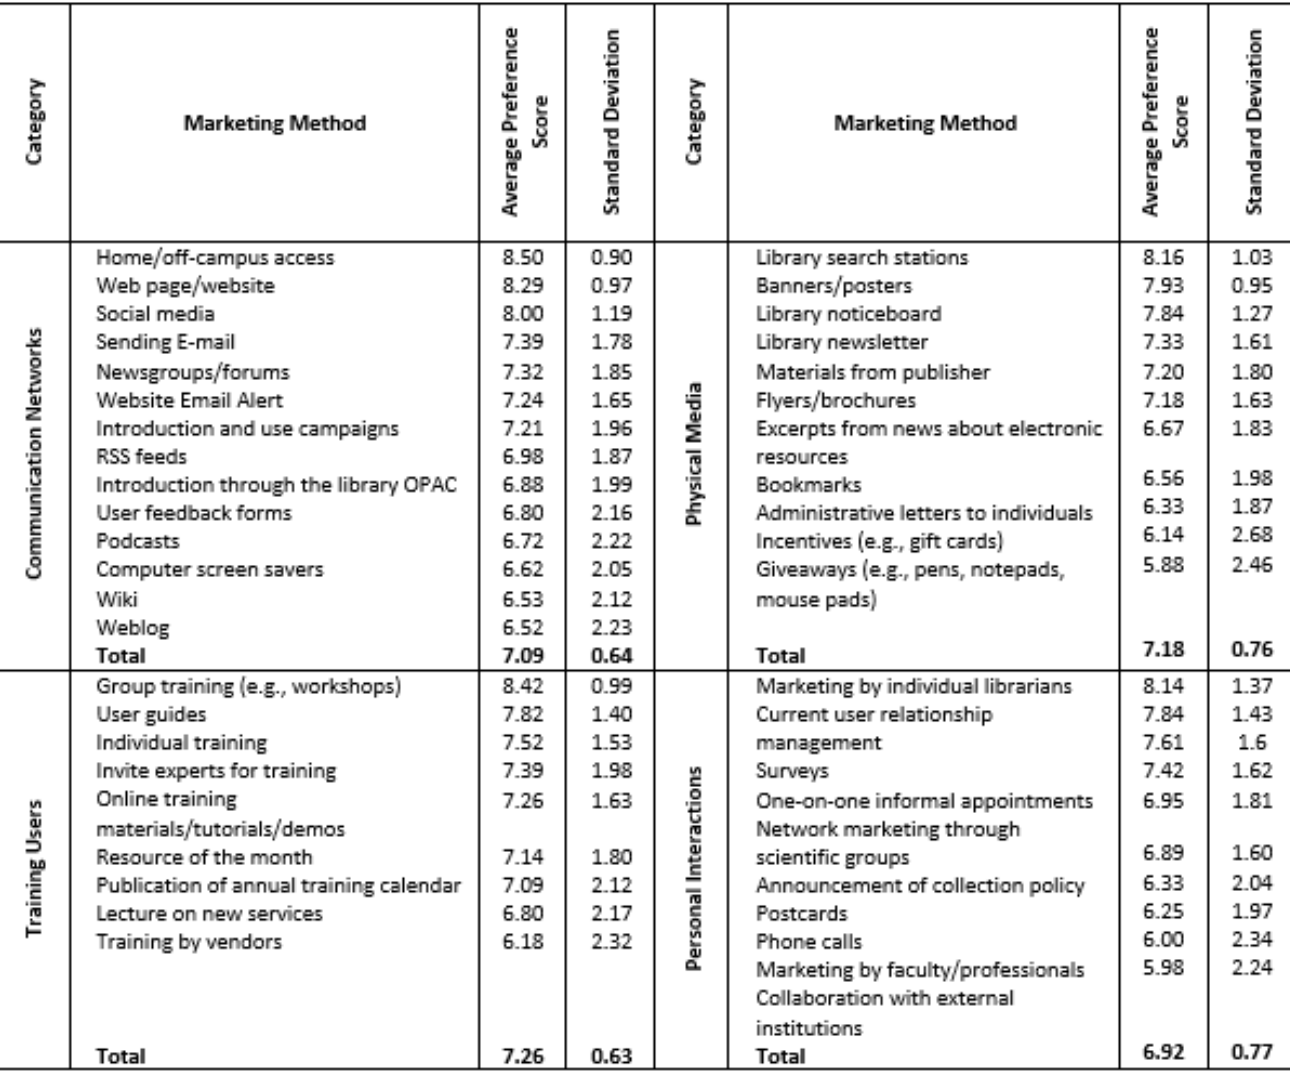
Table 2 Average preference scores of electronic resource marketing methods.